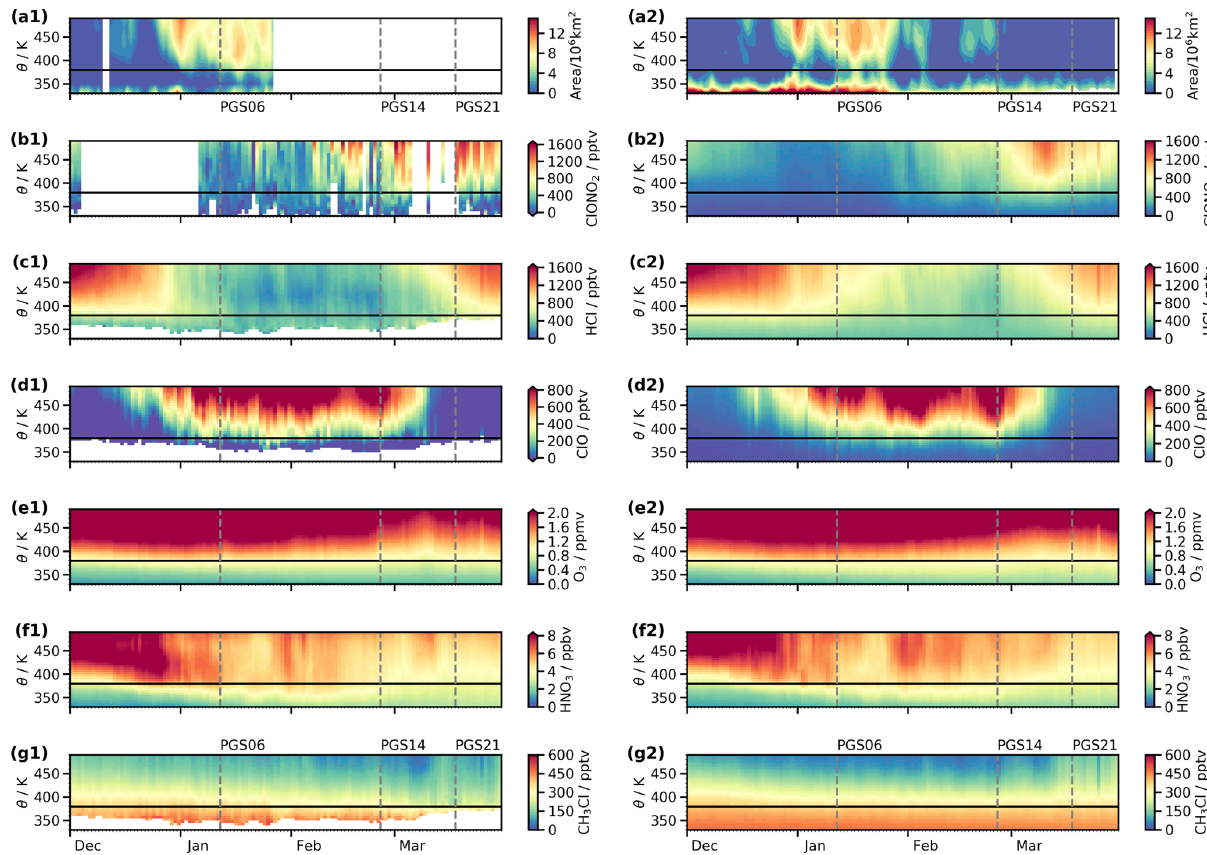
Figure 3. Comparison of MLS, ACE-FTS, and CALIOP time series (left) with CLaMS simulation results (right) for (a) PSC areas, (b) ClONO 2 , (c) HCl, (d) daytime ClO, (e) O 3 , (f) HNO 3 , and (g) CH 3 Cl. The θ = 380K altitude is marked with a black line, and days with aircraft measurements discussed in this paper are marked with dashed lines. Color bars with top and/or bottom arrowheads indicate data greater and/or smaller than the color bar